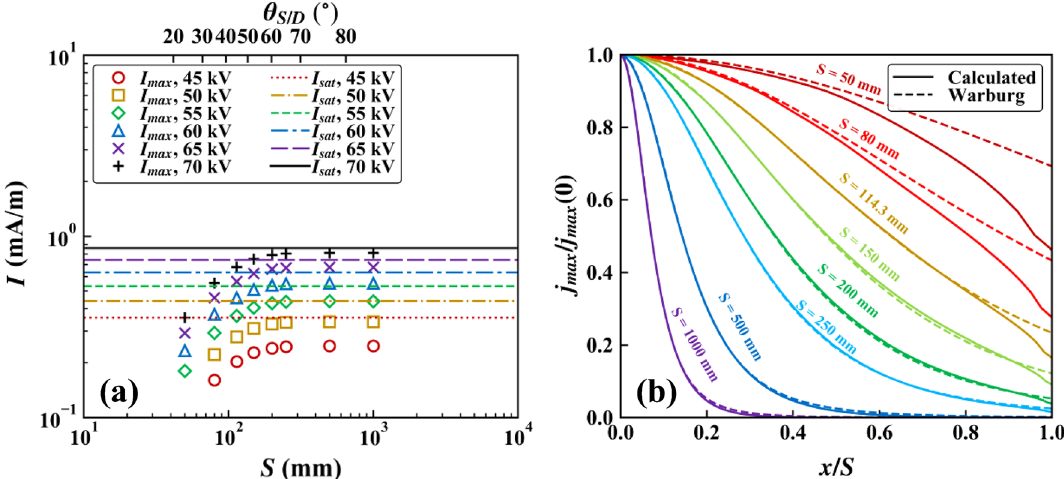
Figure 5. Simulation results of the multiple wire-to-plane configuration: a I max for various S and I sat for the single wire-to-plane configuration under D = 114.3 mm and various V a , and b normalized current density distributions for V a = 60 kV and D = 114.3 mm under various S